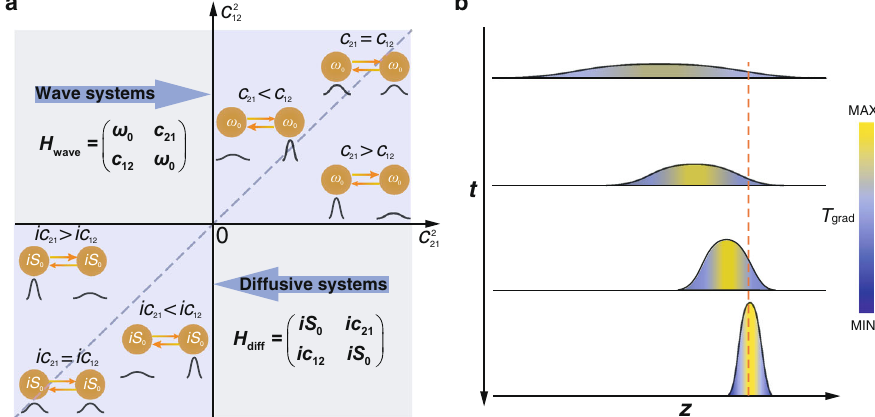
Fig. 1 Asymmetric coupling and heat funneling. a Schematic of coupling dynamics with Hamiltonians in the wave and diffusive systems. The main diagonal elements are the decoupled on-site resonant frequency ( ω 0 ) in wave systems and the decay rate ( iS 0 ) in diffusive systems, the off-diagonal elements are the coupling coef fi cients ( c and ic ). Elements in the diffusive systems are imaginary, indicating the dissipative nature of heat transfer. The black 12 ; 21 12 ; 21 curves describe the fi eld distributions for symmetric and asymmetric couplings. b Concept of the heat funneling effect, showing that the temperature fi eld is rapidly gathered at where we specify (the dashed red line), and fi nally achieve a steady state. t axis indicates the time evolution and z axis is along the coupling